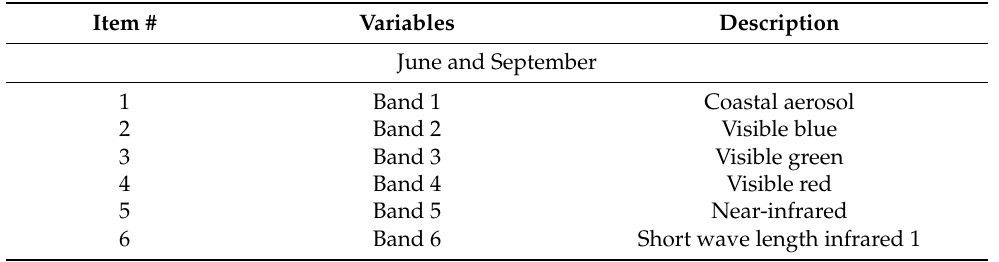
Table A1. Spectral bands and indices of Landsat